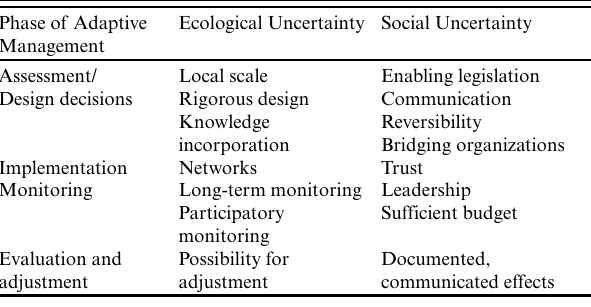
Table 1 . Factors for reducing uncertainties in AM projects, aligned with types of uncertainty and management